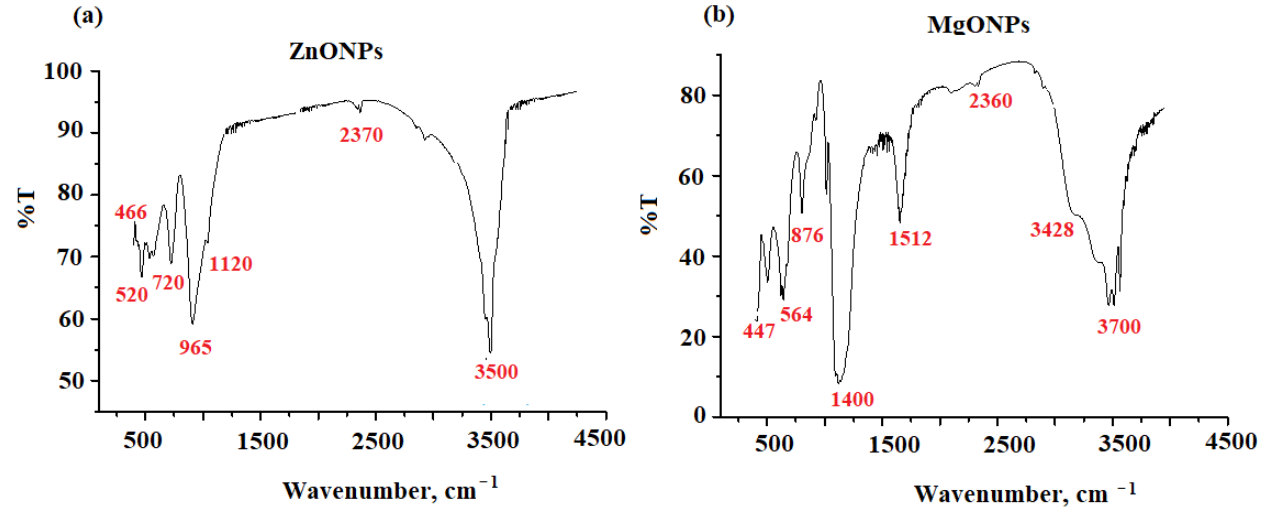
Figure 4. The FTIR spectra of the ( a ) ZnONPs and ( b ) MgONPs measured at wavenumber in the range of 500–4500 cm −1 .